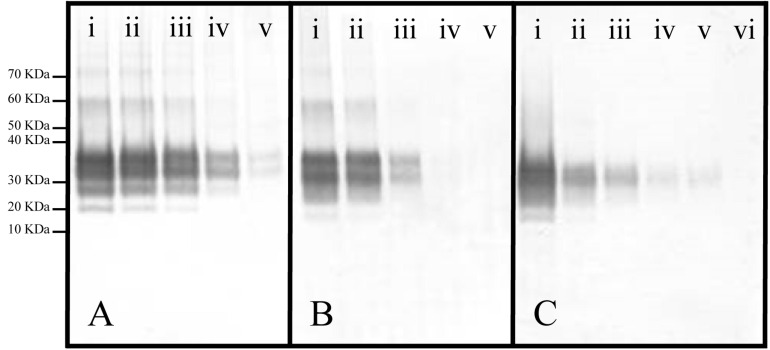
Representative Western blots of panels (A) Ac2O or (B) Ac-NHS reaction mixtures and (C) a dilution series of PrP 27-30 (primary mAb, 3F4). (A) Equal aliquots of a brain homogenate (BH) were reacted with either 0 (i), 5 (ii), 10 (iii), 20 (iv), or 50 mM (v) Ac2O (vide supra). (B) Aliquots of purified PrPSc were reacted with either 0 (i), 1 (ii), 5 (iii), 10 (iv), or 20 (v) mM Ac-NHS. (C) PrP 27-30 was undiluted (i) or diluted 1:3.2 (ii), 1:10 (iii), 1:32 (iv), 1:100 (v), or 1:320 (vi).